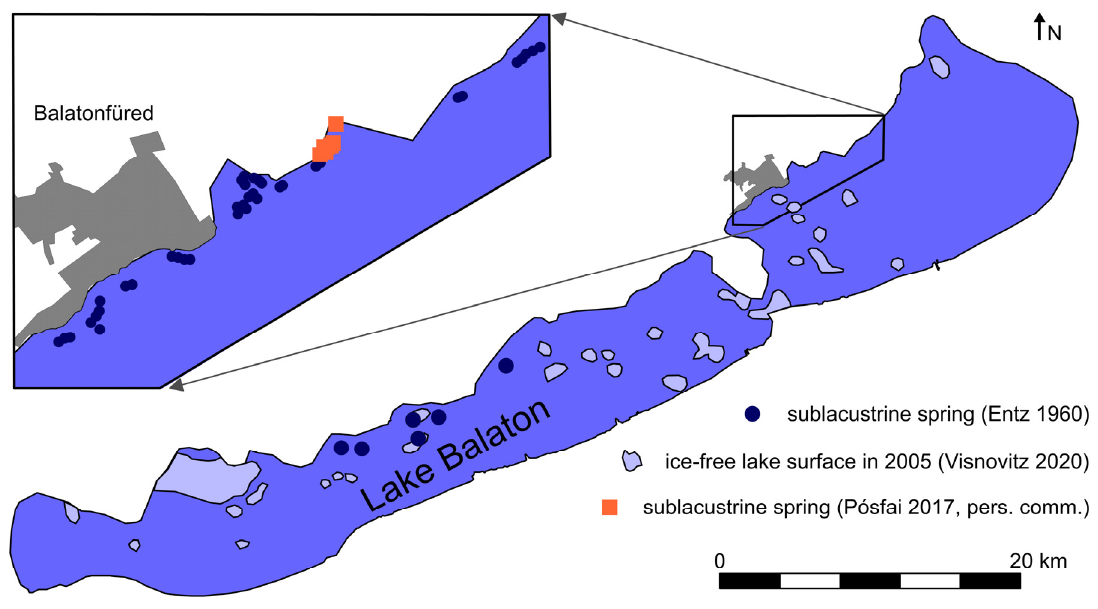
Figure 10. Location of sublacustrine springs (“hevesek”) and the ice-free lake